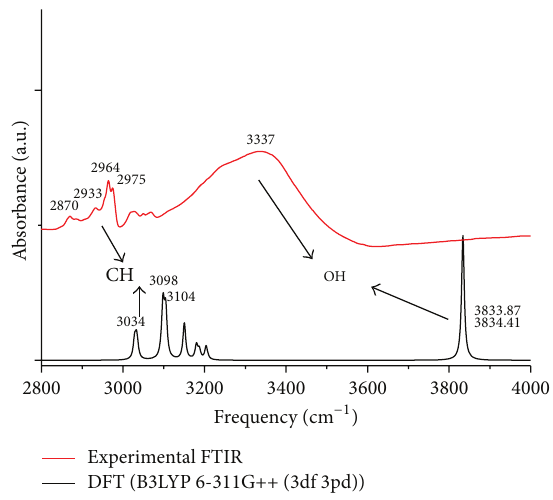
Figure 3: FTIR (2800–4000 cm −1 ) spectra of “Bisphenol A” along with DFT spectra. Values of some peaks are given near the tip of the respective